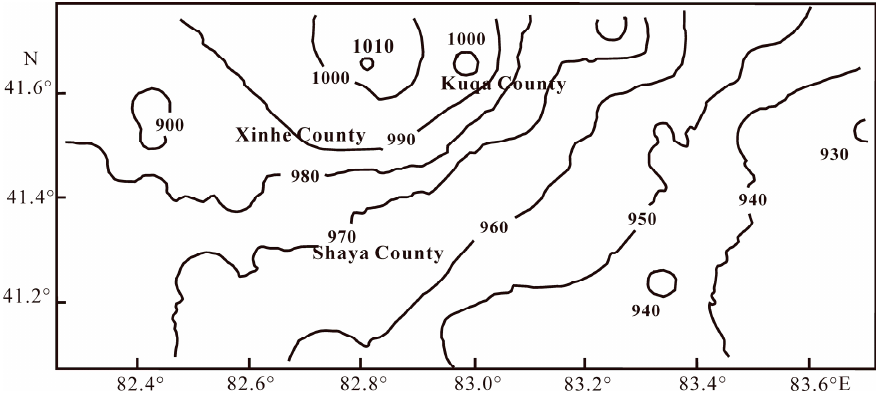
Figure 10. Contour map of Weigan River Basin oasis.